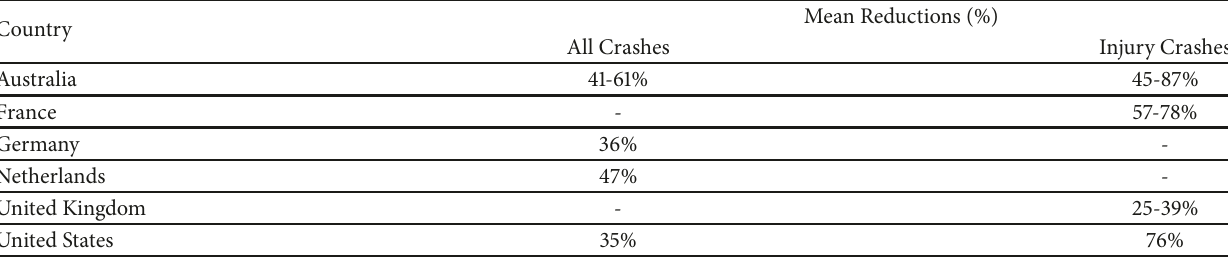
Table 3: Mean crash reductions in various